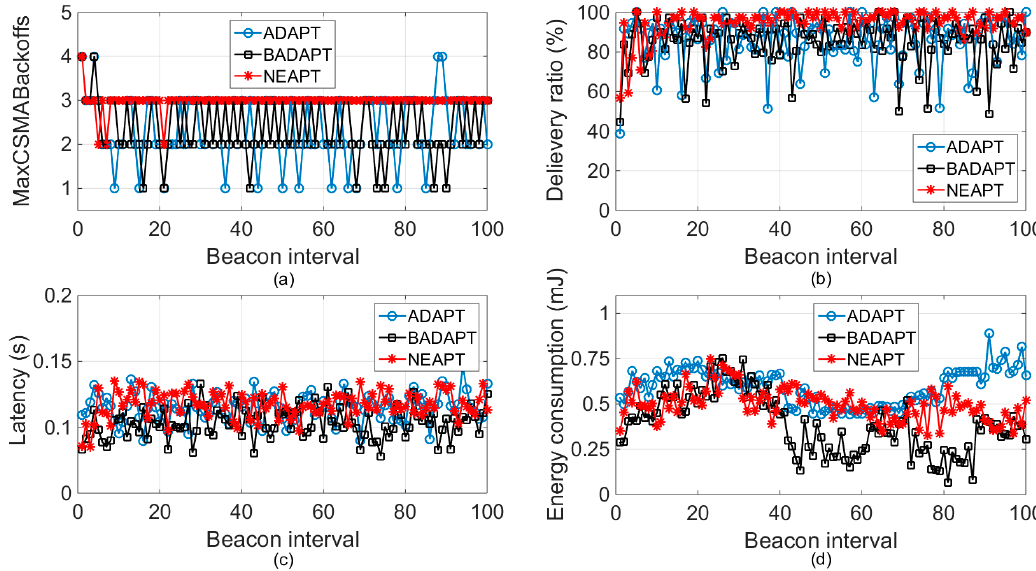
Figure 4. Parameter tuning results and corresponding delivery ratio, energy consumption, and latency with 25 sensor nodes. ( a ) macMaxCSMABackoffs . ( b ) Delivery ratio. ( c ) Latency. ( d ) Energy consumption.